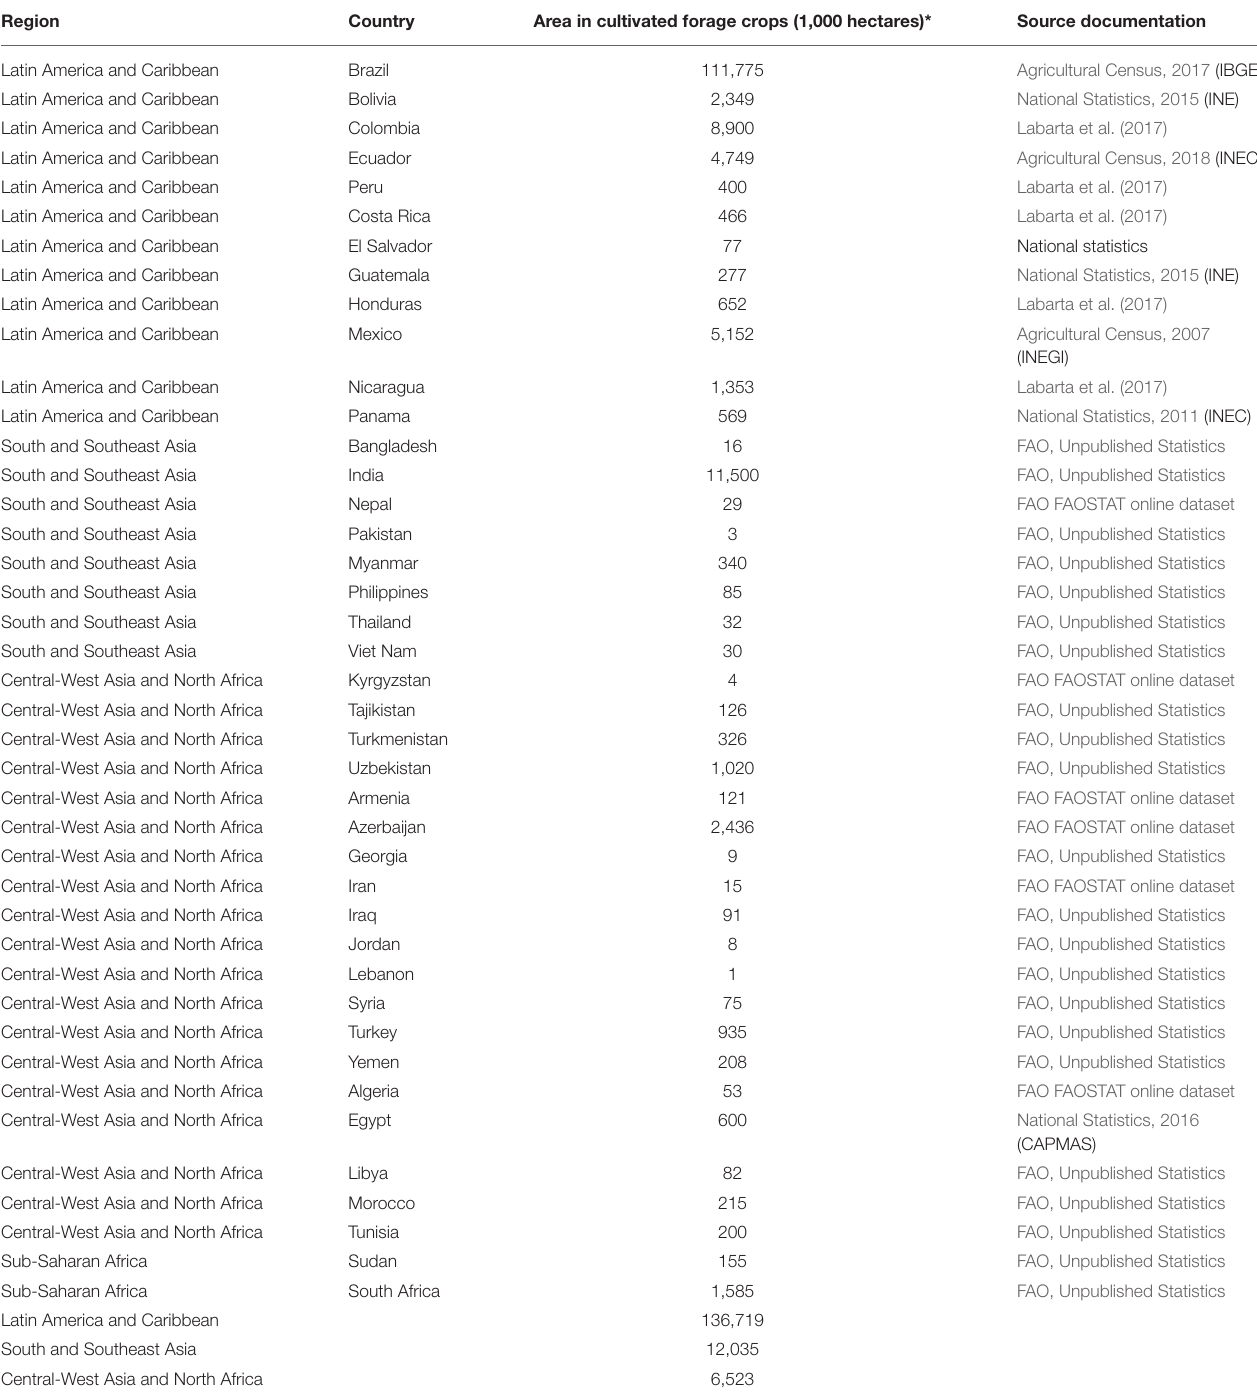
TABLE 1 | Statistics on the extent of cultivated forages in developing countries.